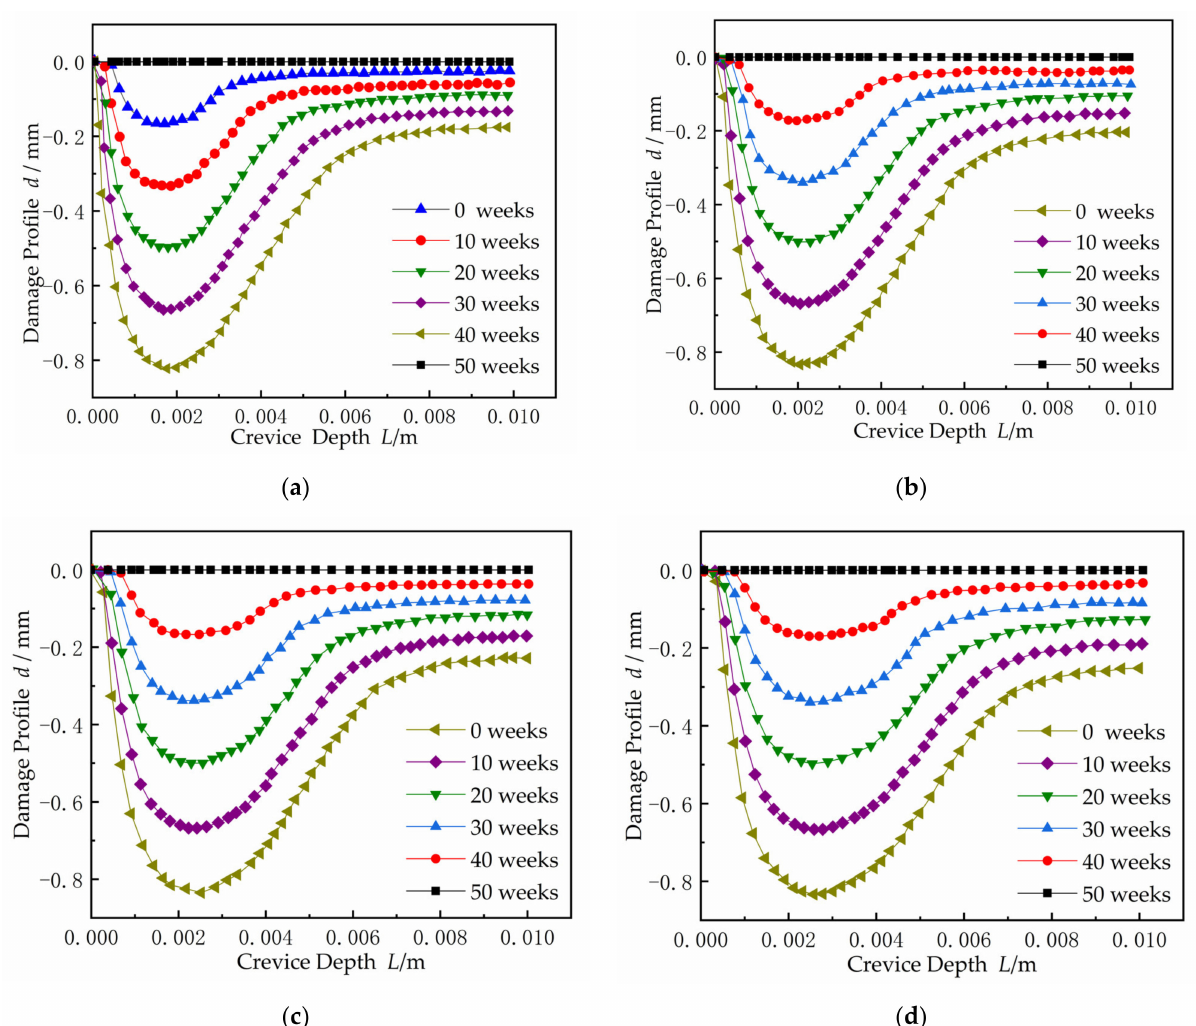
Figure 19. The distribution of damage curves inside the crevice over time ( d denotes damage profile and L denotes crevice depth): ( a ) W = 0.1 mm; ( b ) W = 0.15 mm; ( c ) W = 0.2 mm; ( d ) W = 0.25 mm.